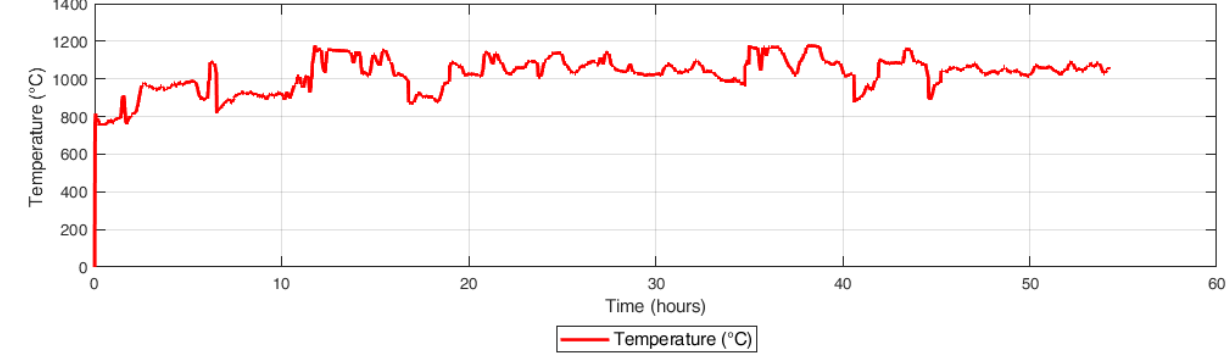
Figure 30. Effect of MPC on temperature